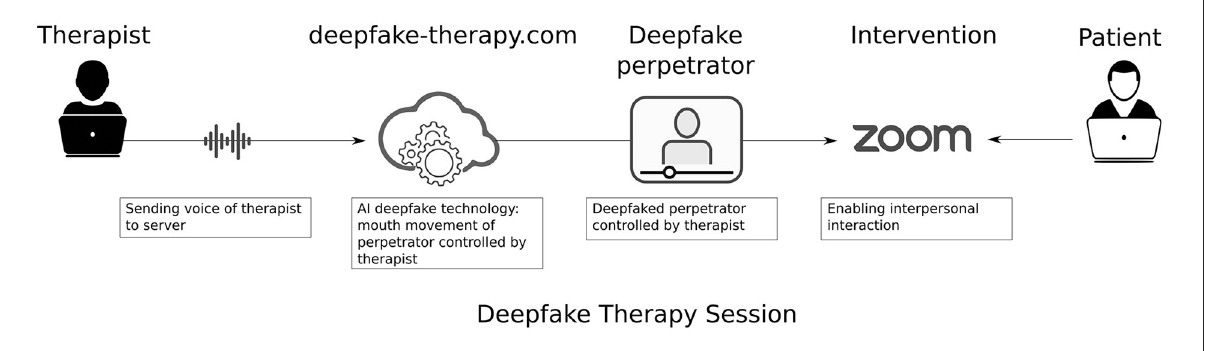
FIGURE1 Overview of deepfake therapy session.